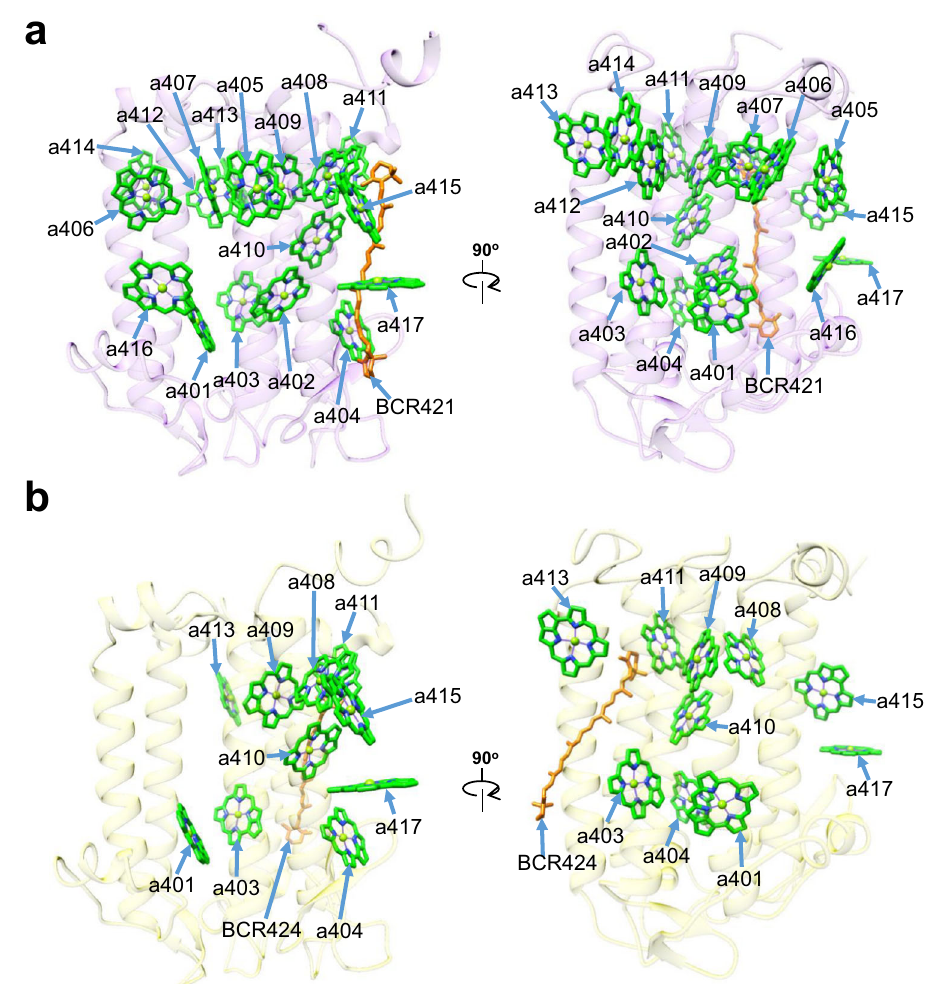
Fig. 3 | Structures of IsiA1-5 and IsiA1-4. Structures of IsiA1-5 ( a ) and IsiA1-4 ( b ) depicted in transparent cartoon model and arrangements of Chl and β -carotene